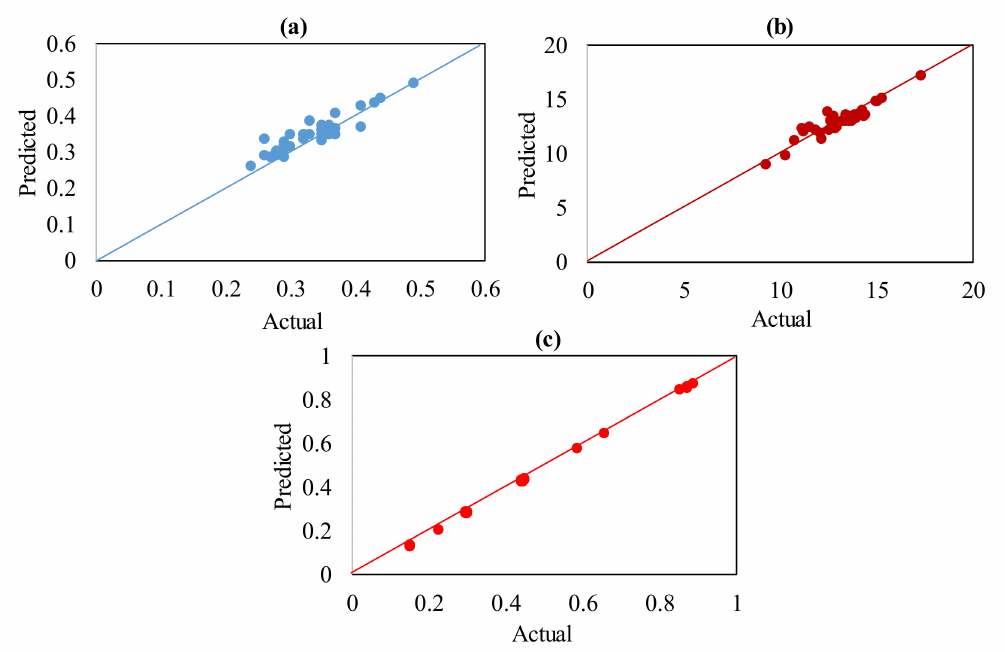
Figure 6. Actual v / s predicted plots for ( a ) Ra, ( b ) EC, and ( c )